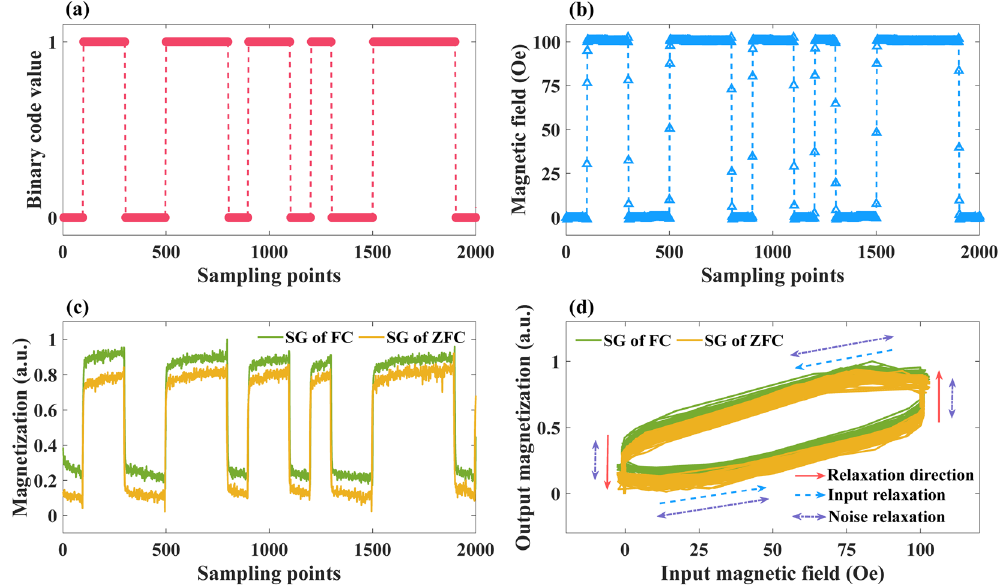
Figure 6. ( a ) Randomly generated binary sequence. In the ideal case, binary code only takes two values—0 and 1. ( b ) Input magnetic field applied by PPMS-VSM according to the binary sequence. The scattered points between 0 and 100 Oe are caused by the non-transient magnetic field applied by the system. ( c ) Magnetization (a.u.) of FC and ZFC relaxation in LFCS at 150 K. ( d ) Relationship curve between input magnetic field and the output magnetization (a.u.) of FC and ZFC relaxation in